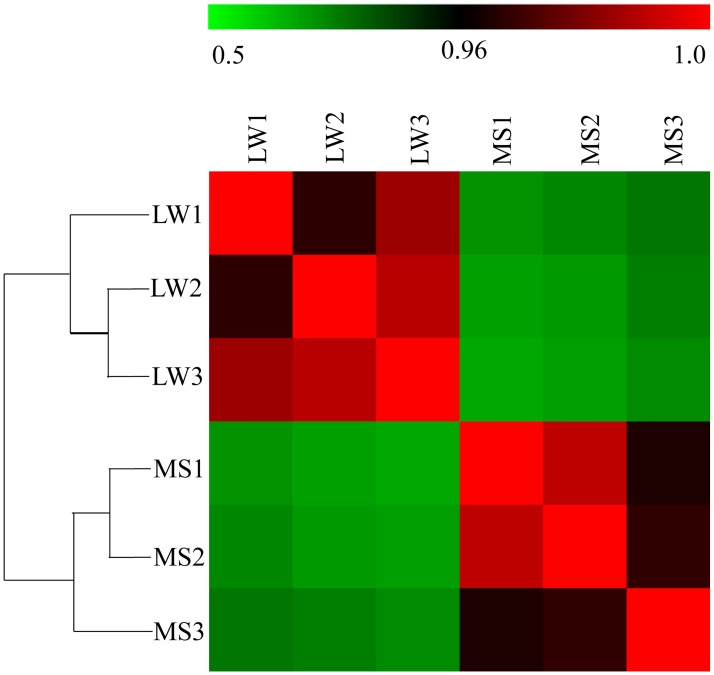
Hierarchical clustering analysis and heat map matrix of Pearson correlations of the reads counts of 1147 unique miRNAs between Large White (LW) and Meishan (MS).LW1, LW2 and LW3 refer to the three biological replications of Large White pigs; MS1, MS2 and MS3 refer to the three biological replications of Meishan pigs. The color legend at top represents the correlation coefficient.